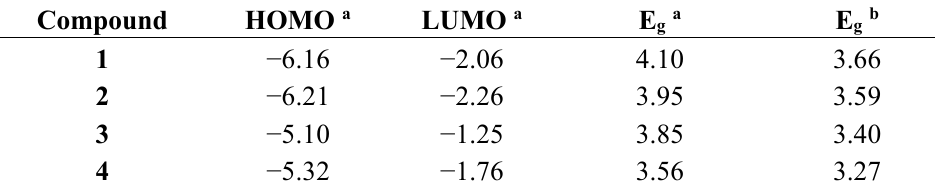
Table 4. Calculated and experimental parameters for 1 – 4